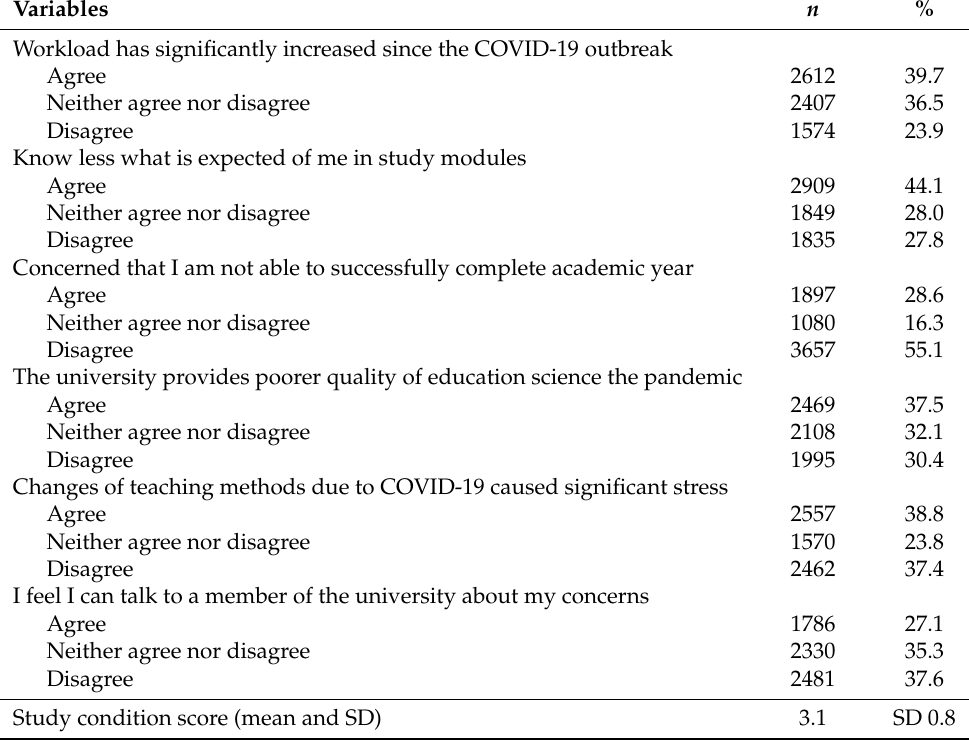
Table 5. Perceived study conditions among university